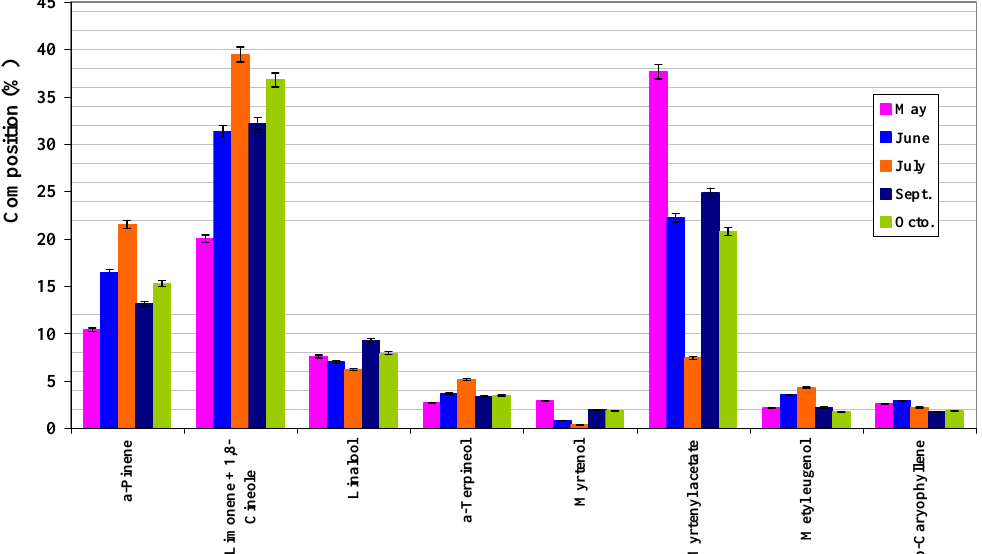
Figure 1. Composition of main compounds of leaves essential oil of Portuguese